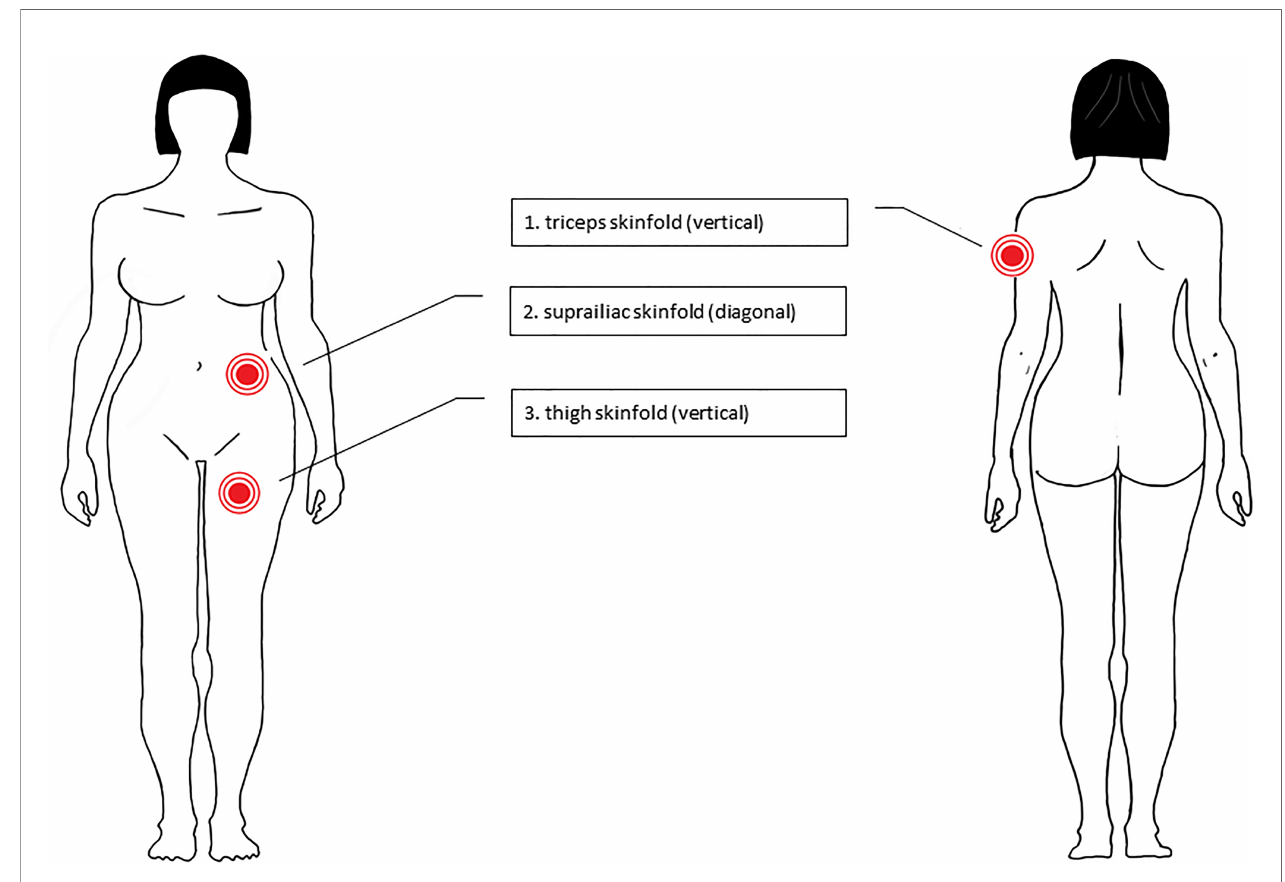
FIGURE 2 | Plicometry sites of measurement (58, 59). Skinfold measurement using the 3 point-method (1 = triceps, 2 = suprailiac skinfold; 3 =